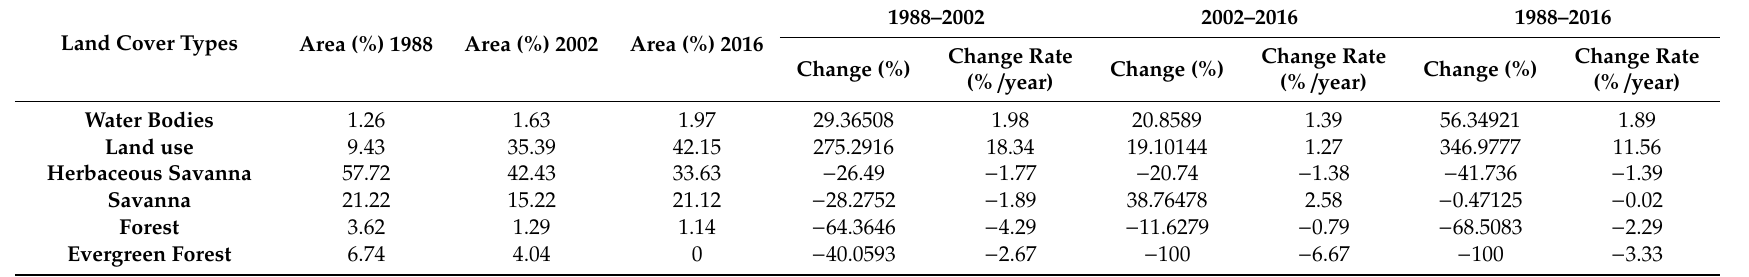
Table 2. Land use land cover change trend